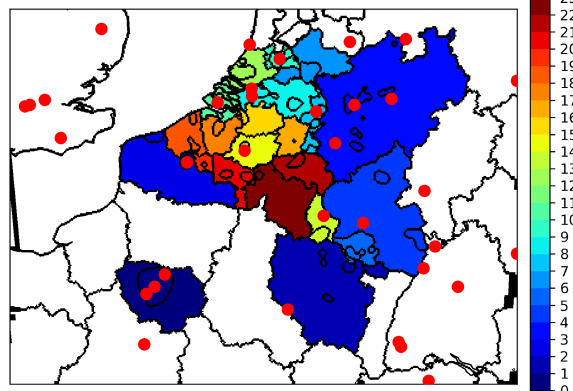
Figure 4. Main area of interest, i.e. the 23 administrative regions where major urban areas (contours of the urban areas also repre- sented here) and point source emissions are controlled separately for anthropogenic emissions in the 2km × 2km resolution zoom of the CHIMERE transport model. The names of these administrative regions are listed in Table 1. Ground-based 14 CO 2 and CO 2 obser- vation sites are also shown (red dots; see Fig. 7, for the network on the whole domain).